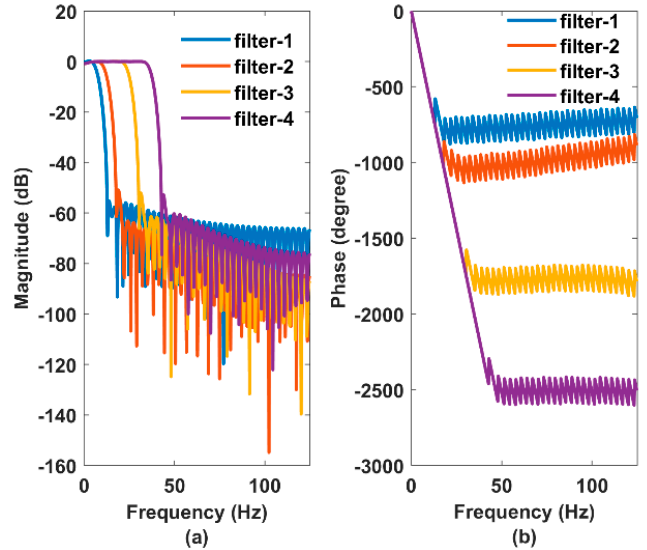
Figure 6. Bode plot of the 80th order FIR Hamming window filters where ( a ) shows the magnitude responses and ( b ) shows the phase (unwrapped) responses.